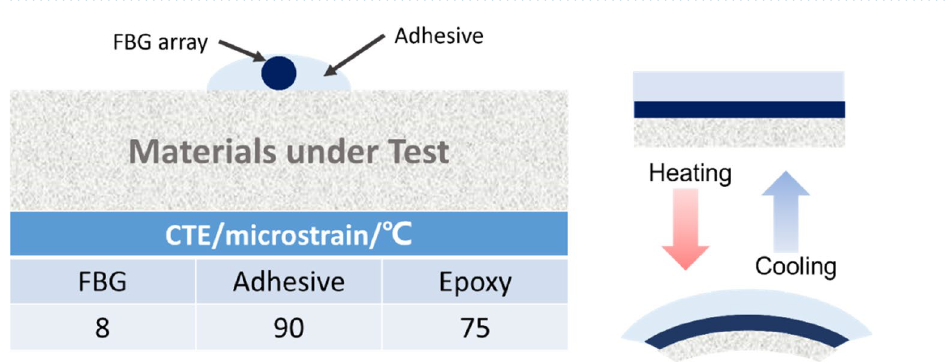
Figure 31. Nanocrystalline structure of BaTiO 3 nanoparticles well-dispersed within the area over which the extrinsic strains are measured by the FBG sensors.